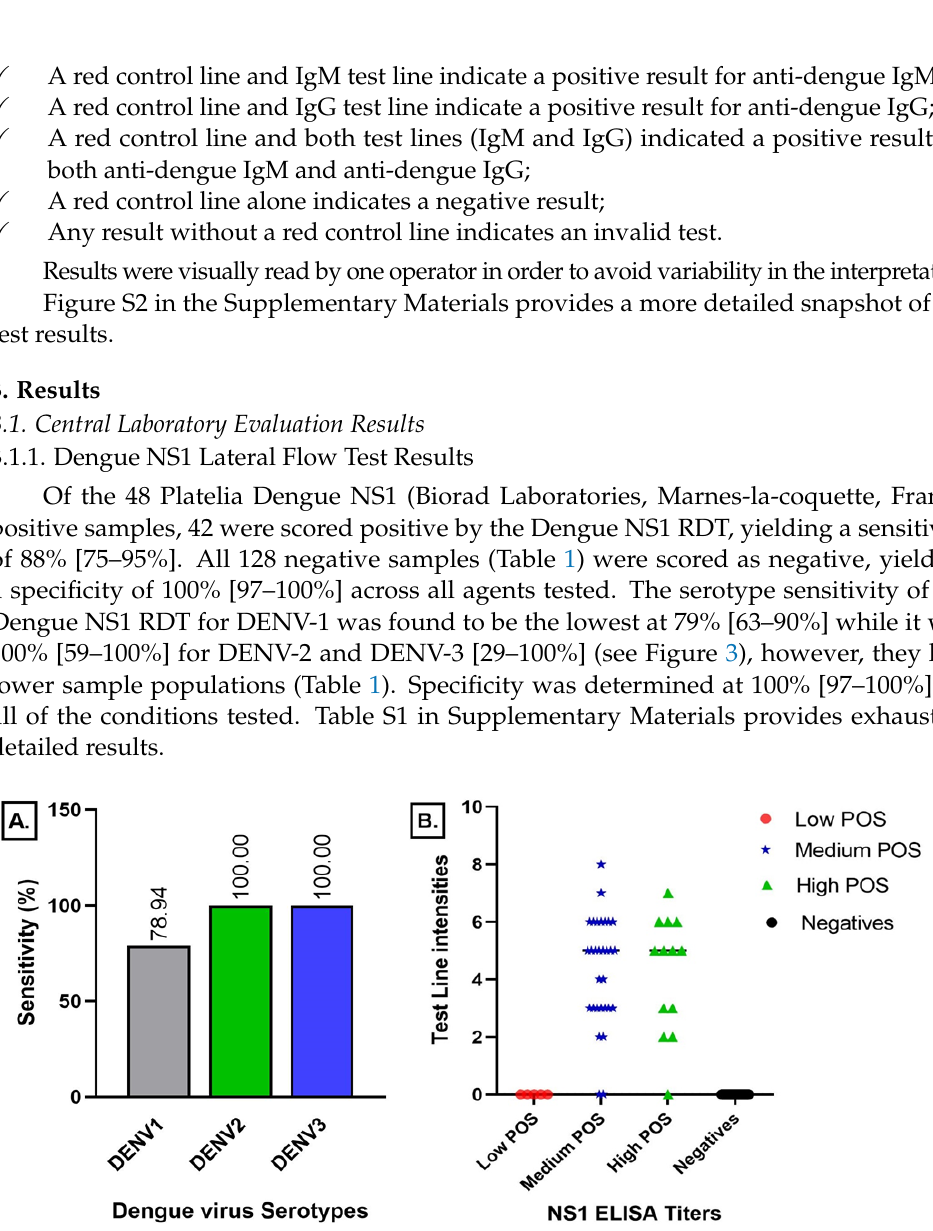
Figure 4. Sensitivity of the IgG/IgM RDT versus ELISA IgM ratio ( A ) and MAC ELISA titres ( B ). 3.1.3. Dengue IgG Lateral Flow Test Results A sensitivity of 70% [59 – 79%] was found with the sensitivity panel samples. A spec- ificity of 91% [79 – 98%] was found with cross reacting flaviviruses (ZIKV, YFV) and inter- fering conditions (malaria, rheumatoid factor). See Table S3 in the Supplementary Mate- rials for exhaustive detailed results. Figure 5 shows the distribution of the test line inten- sities depending on the sample characterisation .